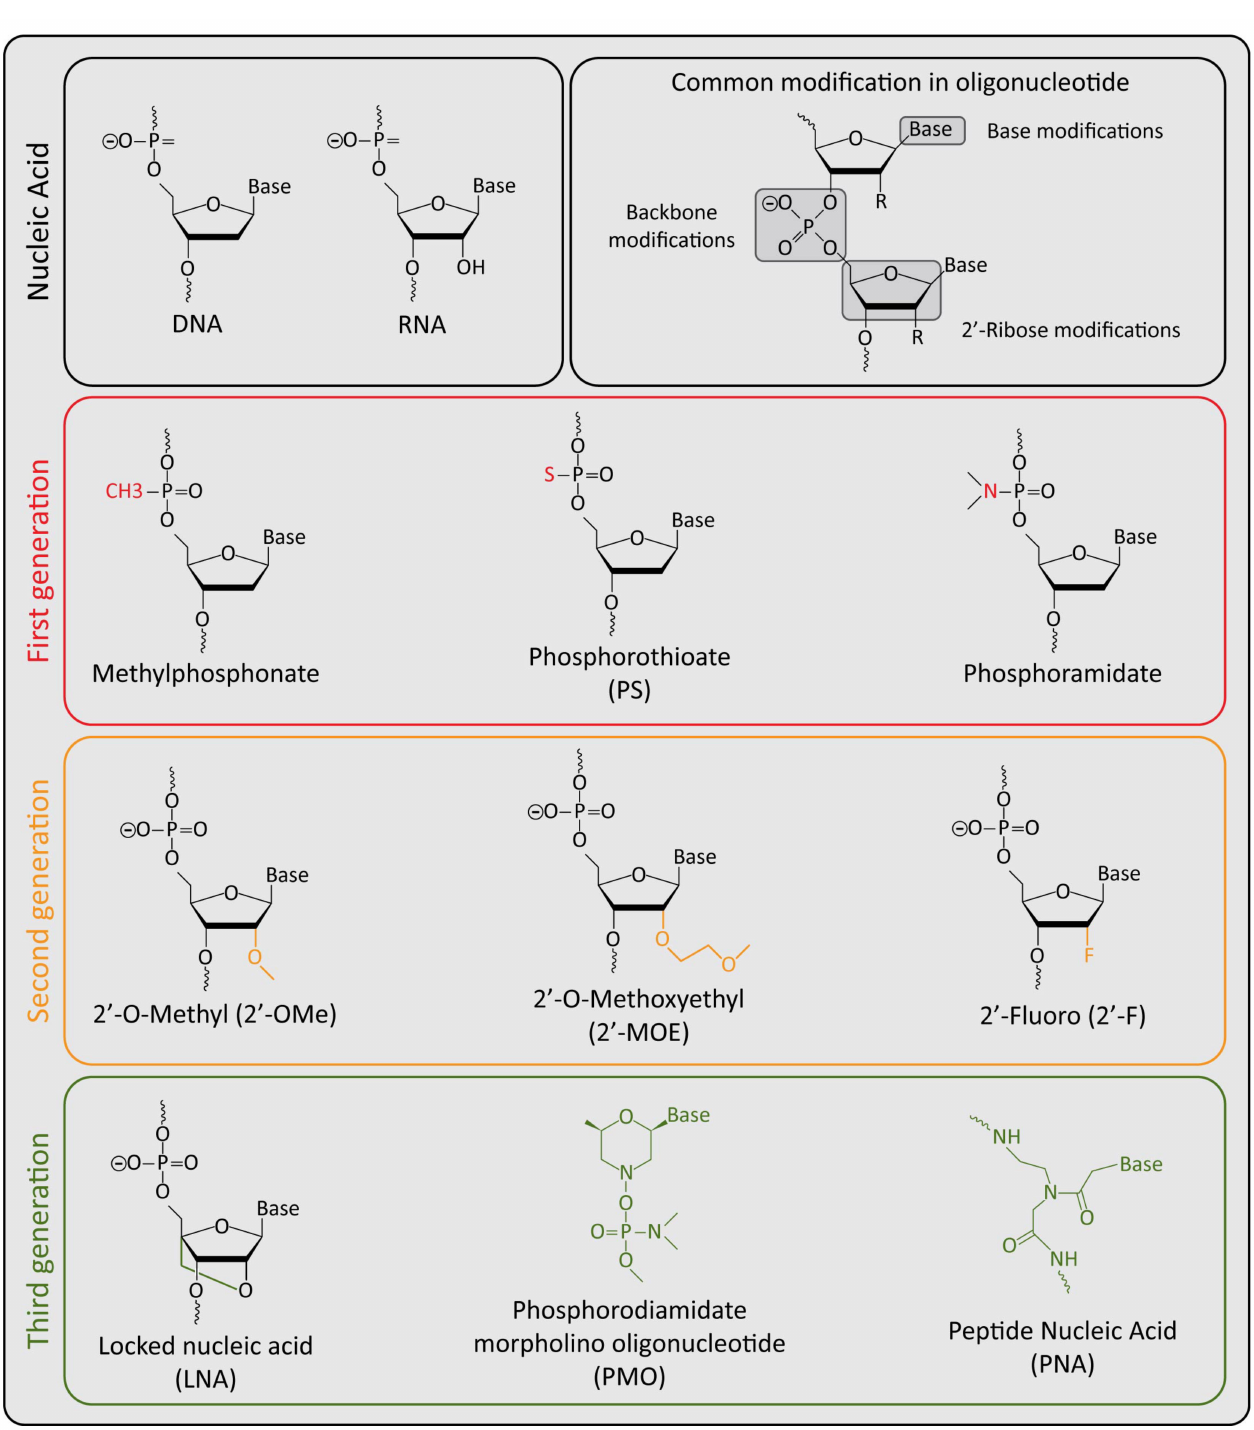
Figure 2. Graphic representation of chemical specific characteristics for each generation ASOs. Main chemical differences from common shared structure are marked with